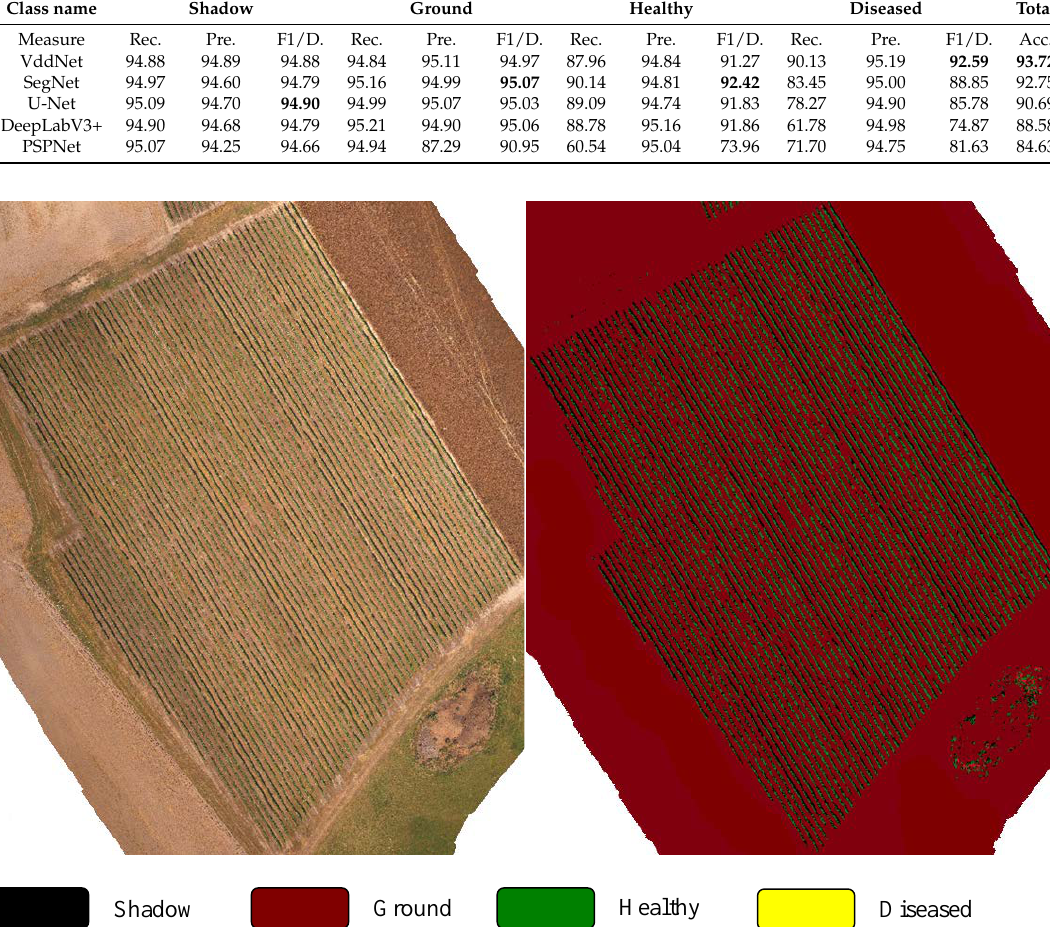
Figure 10. Qualitative result of VddNet on a healthy parcel with brown ground. The visible orthophoto of the healthy parcel is in the left side, and its disease map in the right